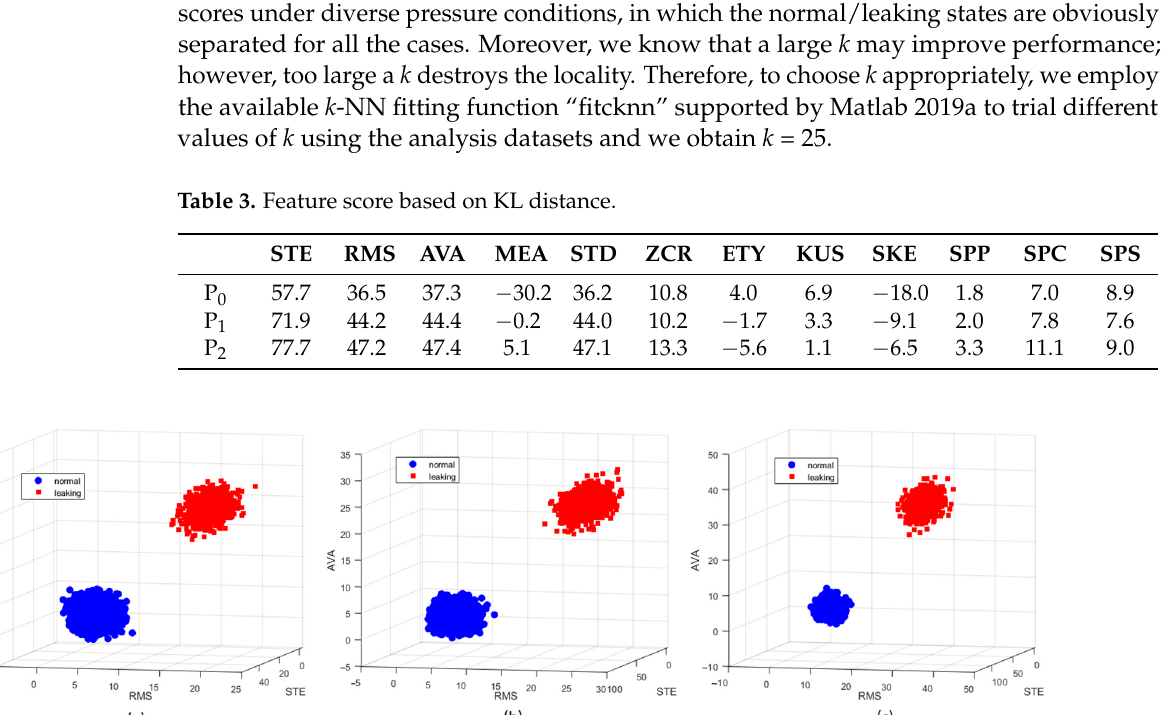
Figure 5. Three-dimensional visualization of the three most highly ranked features under various pressure conditions: ( a ) P 0 , ( b ) P 1 , ( c ) P 2.